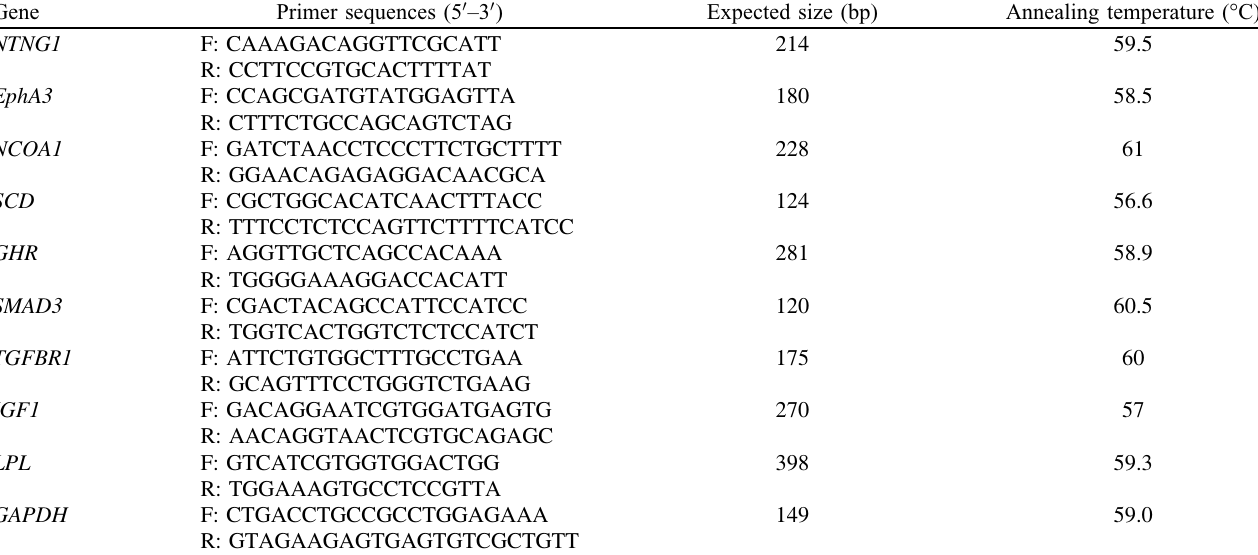
Table 1. Primer sequences for qRT-PCR analysis of gene transcripts. Gene